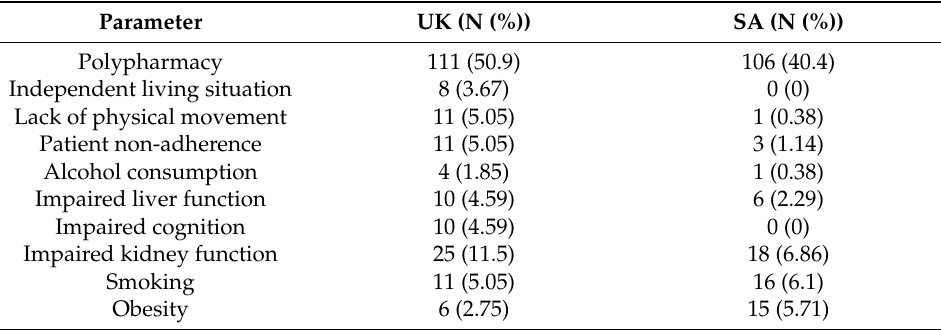
Table 4. The reported risk factors from both